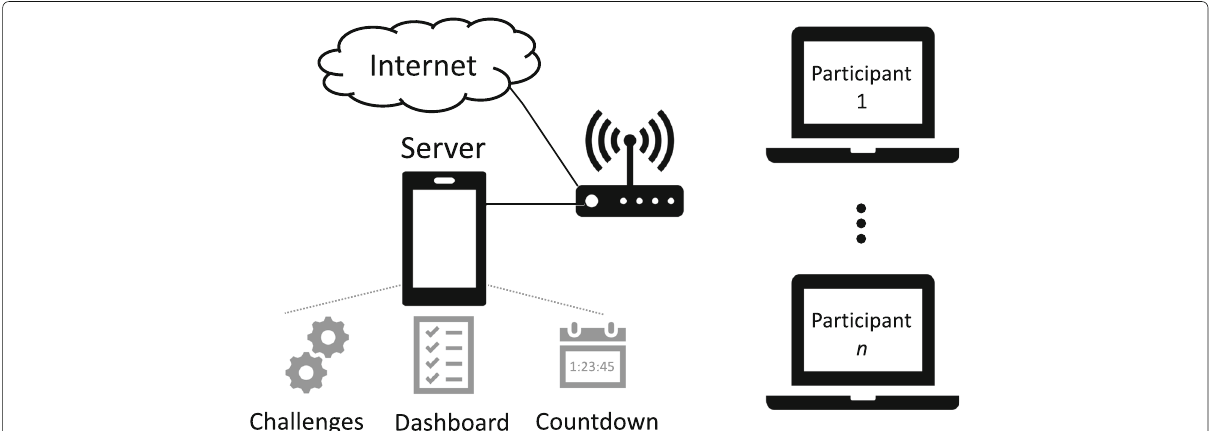
Fig. 3 Architecture of CyberSecurity Challenges infrastructure